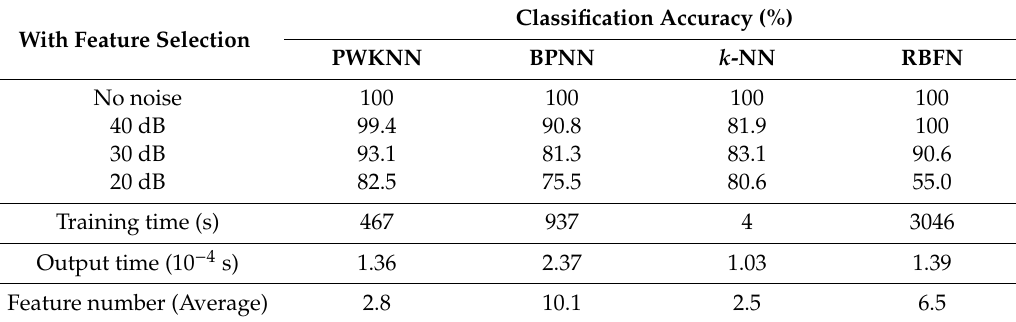
Table 4. The classification results with feature